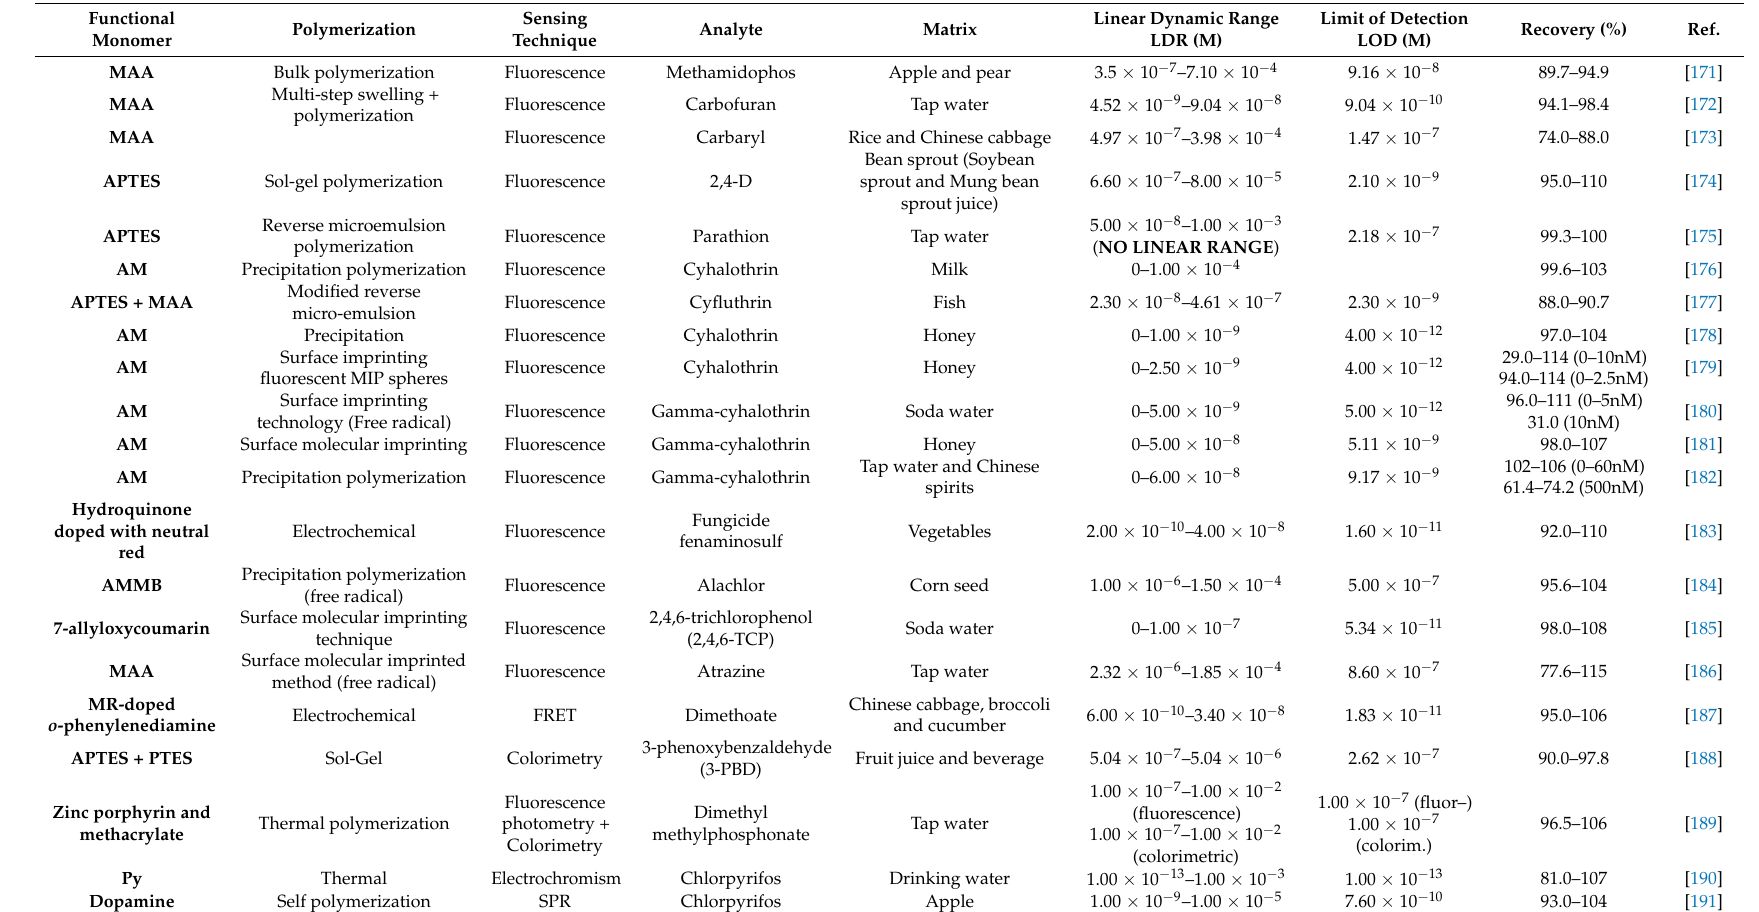
Table 6. Optical MIP sensors for pesticides detection in food: main features and